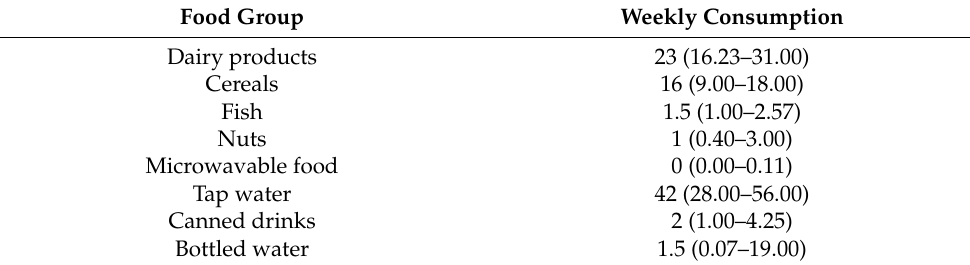
Table 2. Weekly consumption (servings/food or drink item) of the different food groups among the women participating in the study ( n =